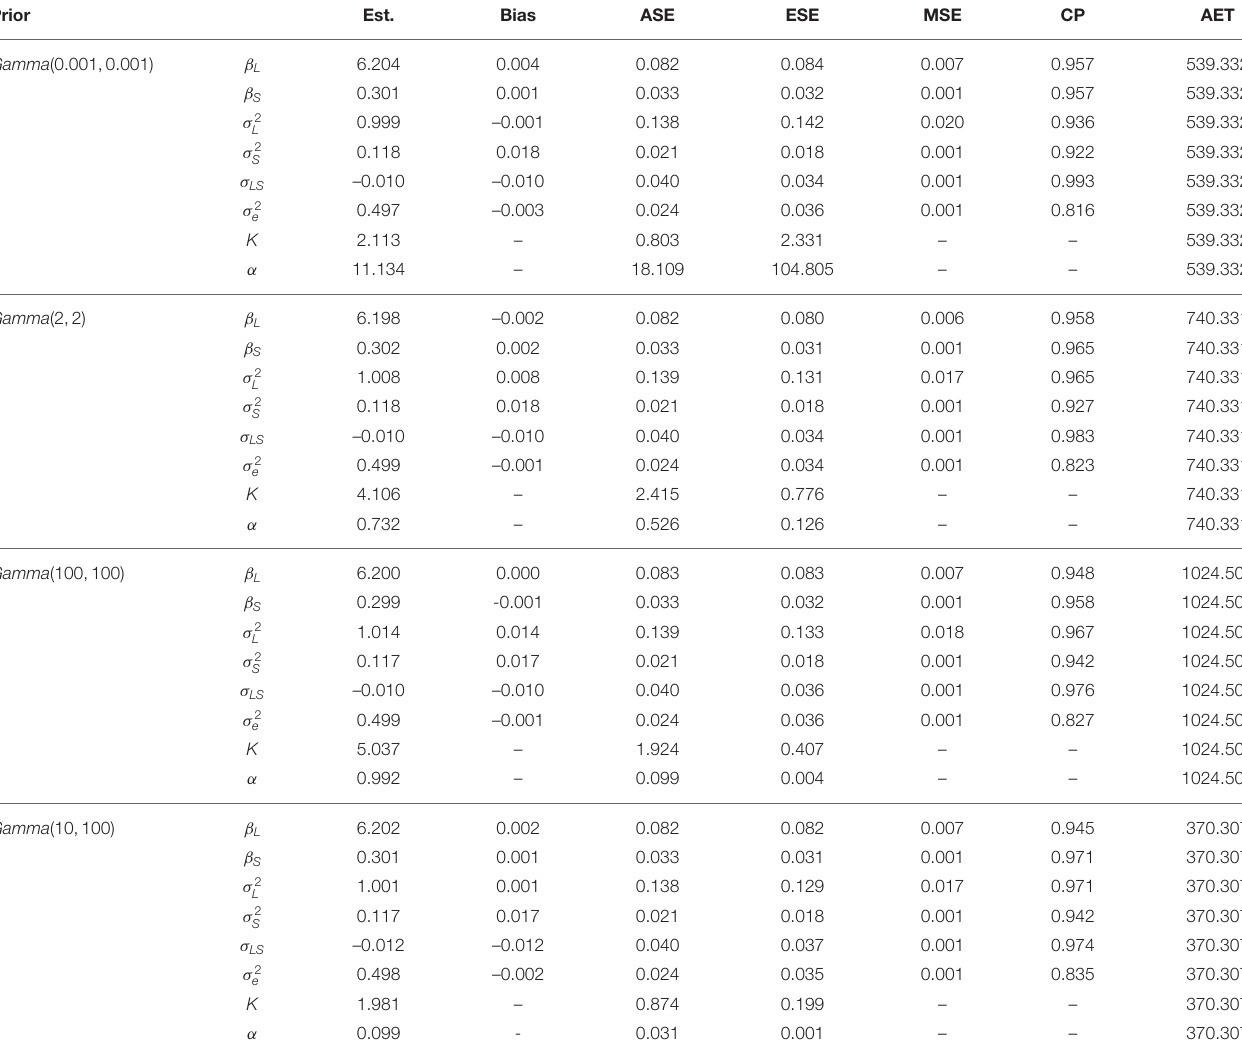
TABLE 2 | Model estimation for BNP growth curve modeling with different precision parameter priors when data are normal and N = 200. Prior Est. Bias ASE ESE MSE CP AET Gamma